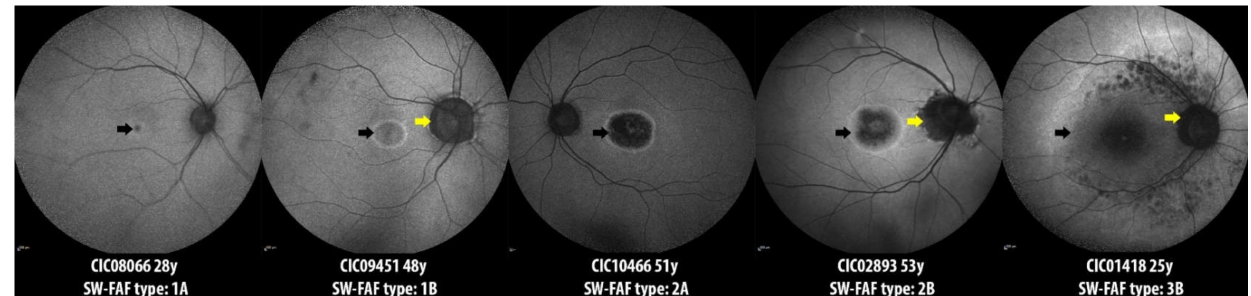
Figure 5. The short wavelength fundus autofluorescence (SW-FAF) qualitative analysis. Patients were classified according to the SW-FAF pattern as follows: group 1—the dimension of the central hypoautofluorescence (black arrows) is inferior to 1 disc diameter (DD); group 2—the dimension of the central hypoautofluorescence exceeds a 1 disc diameter (DD) but stays within the macula; group 3—the central hypoautofluorescence extends beyond the macula. Furthermore, two subgroups were considered: subgroup A when peripapillary sparing was present; subgroup B when the peripapillary area was involved by the disease (yellow